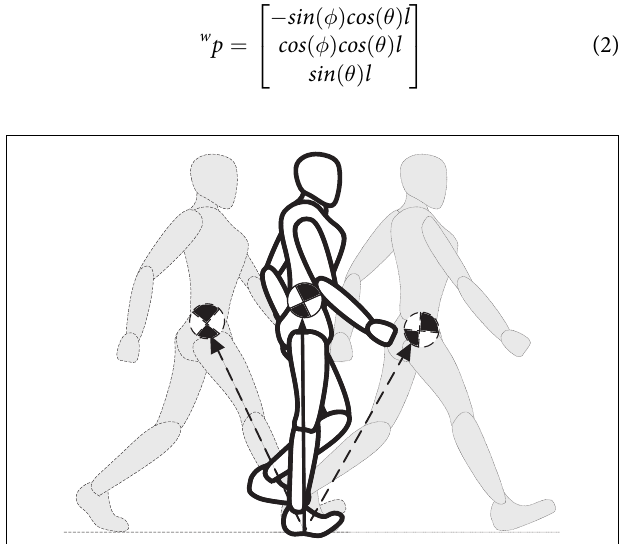
FIGURE 1 | Biomechanical model for human balance and walking as an inverted pendulum